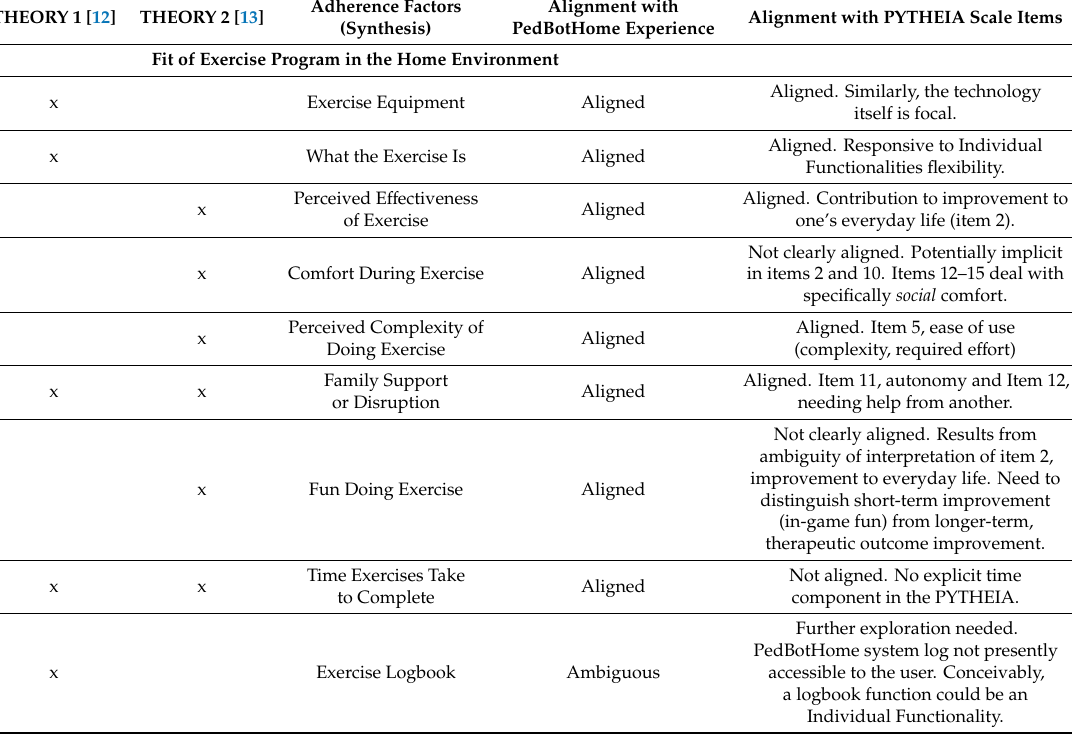
Figure 3. Comparative home exercise program adherence theories. Table 3. Home exercise programs (HEP) adherence theory alignment with PedBotHome experience and PYTHEIA [31] scale items.